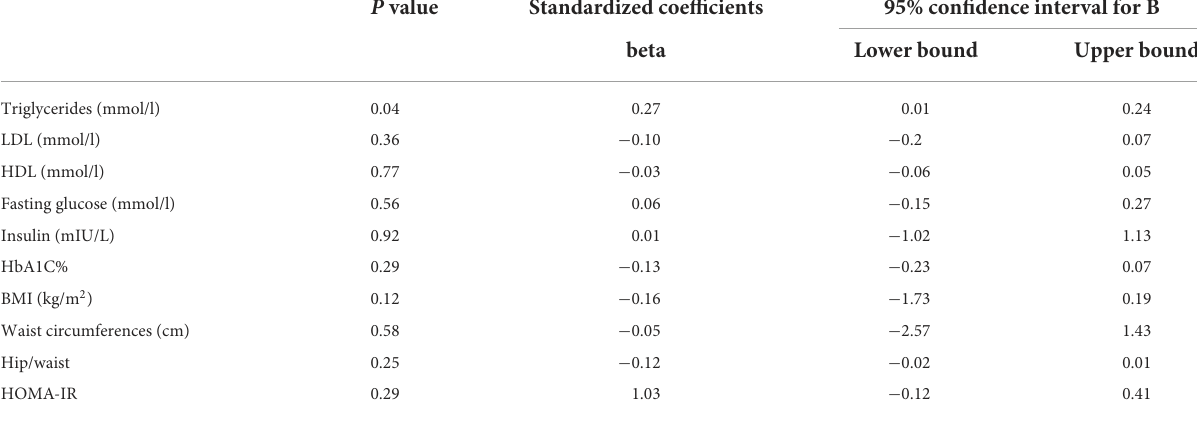
TABLE 7 Regression analysis of total 24-h sleep duration with metabolic components after adjustment for age and afternoon siesta (napping) and night sleep